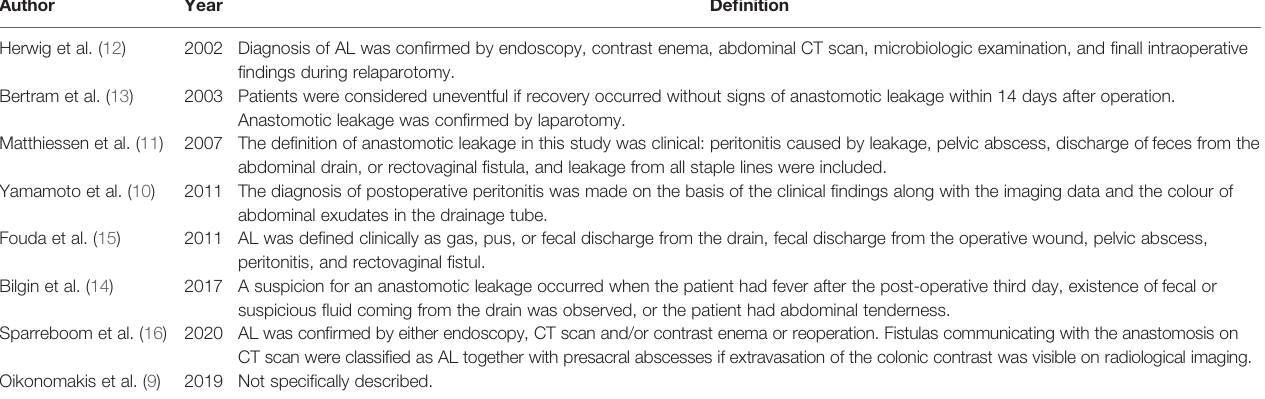
TABLE 2 | De fi nition of anastomotic leakage of included studies.